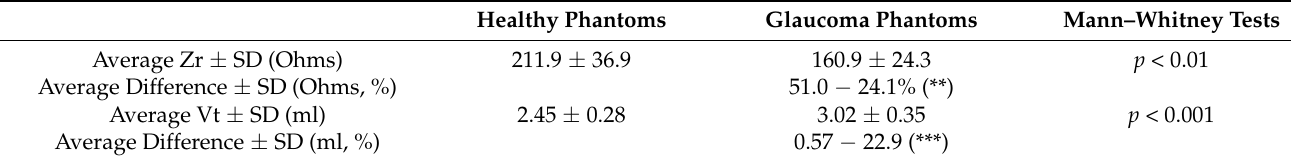
Table 4. Description of data obtained on Healthy and Glaucoma Phantoms.